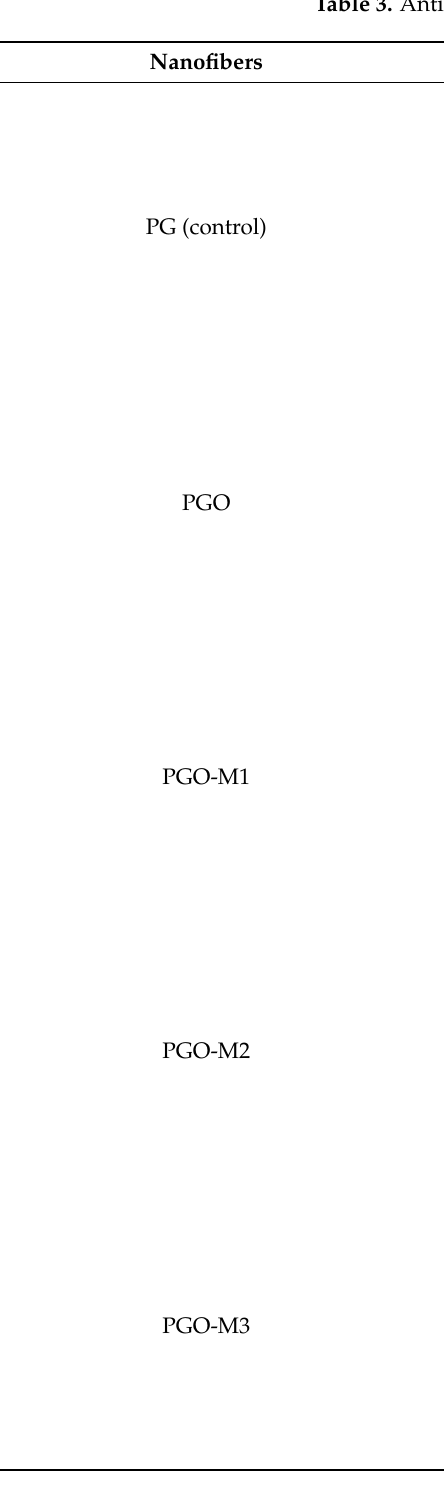
Table 3. Antimicrobial activity of nanofibers against S. aureus and E. coli (average CFU/mL).